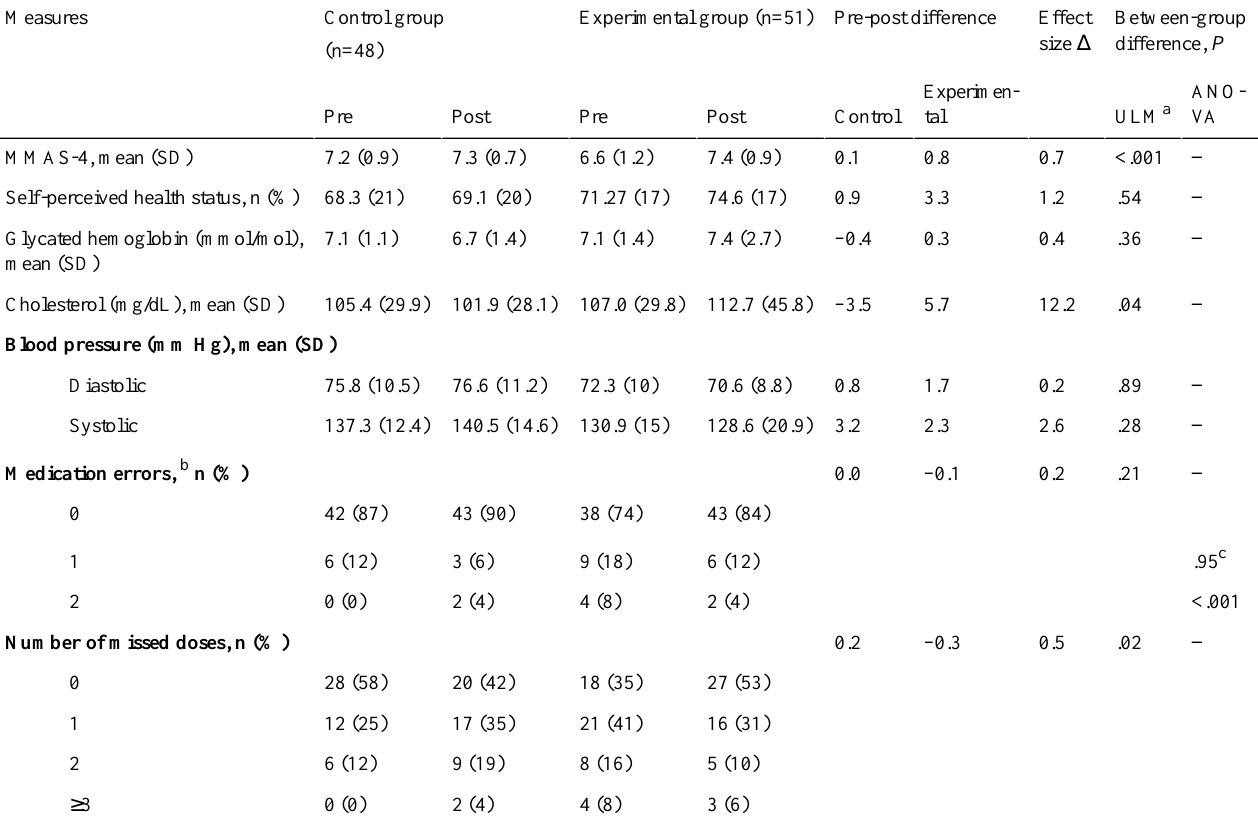
Table 2. The 4-item Morisky Medication Adherence Scale (MMAS-4) scores and rates of missed doses and medication errors reported by patients in the control and experimental